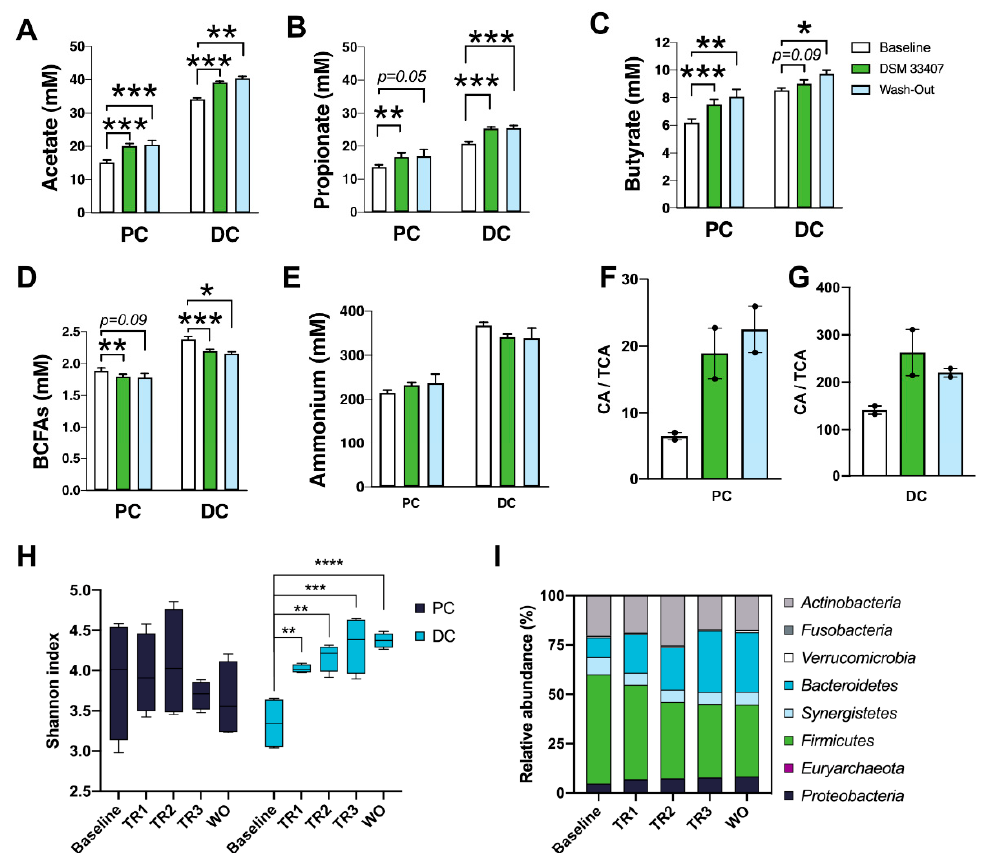
Figure 4. C. minuta DSM33407 improves gut microbiota diversity and changes microbial metabolism in a Simulator of the Human Intestinal Microbial Ecosystem (SHIME ® ) primed with human obese colonic microbiota. The main short-chain fatty acids acetate ( A ), propionate ( B ), and butyrate ( C ), as well as branched-chain fatty acids (BCFAs) ( D ) and ammonium ( E ) concentrations were measured in the proximal and distal colon (PC and DC, respectively) at three time-points, namely baseline (Baseline), after three weeks of treatment (DSM33407), and during the wash-out period (Wash out). Similarly, the ratio of unconjugated over conjugated forms of the primary bile acid cholic acid was measured in proximal ( F ) and distal ( G ) colon (n = 2). Shotgun metagenomics data were collected weekly at baseline, during the three weeks of treatment (TR1, TR2, and TR3, corresponding to first, second, and third week of treatment, respectively) and during wash-out (WO) to evaluate gut microbiota diversity using the Shannon Index ( H ) and relative abundance at the phylum level ( I ). Key: CA, Cholic Acid; TCA, Taurocholic Acid. Statistics: mixed REML followed by uncorrected Fischer’s LSD ( A – E ); H: Statistics done independently for each compartment. One-way ANOVA followed by Dunnett’s test with Baseline as control group. * p < 0.05, ** p < 0.01, *** p < 0.001, **** p <